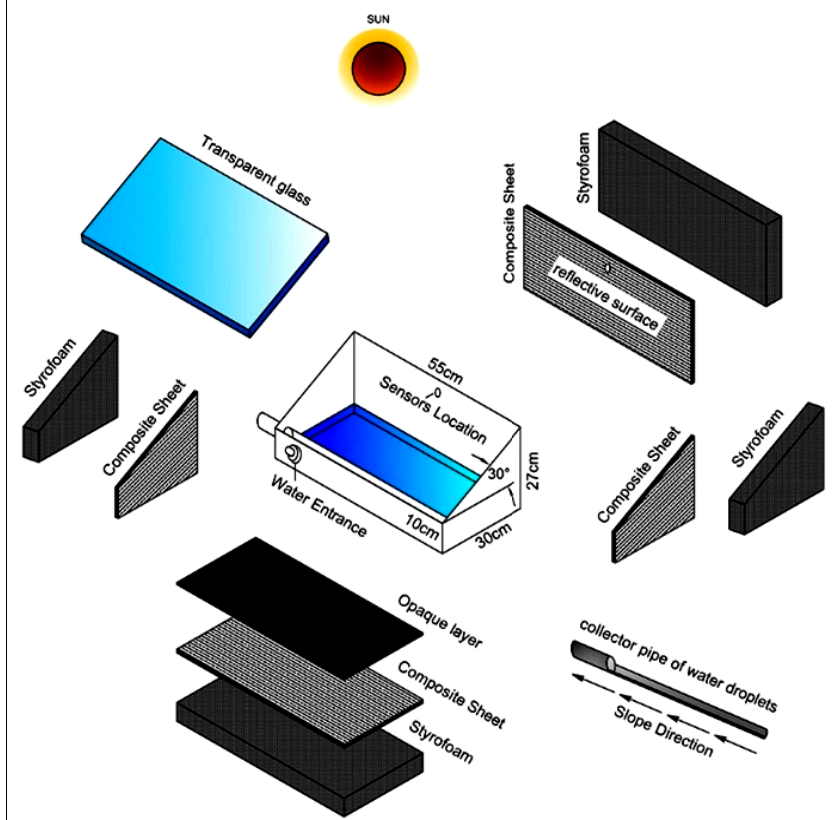
Figure 3. General schematic diagram of the solar desalination unit used in the study.